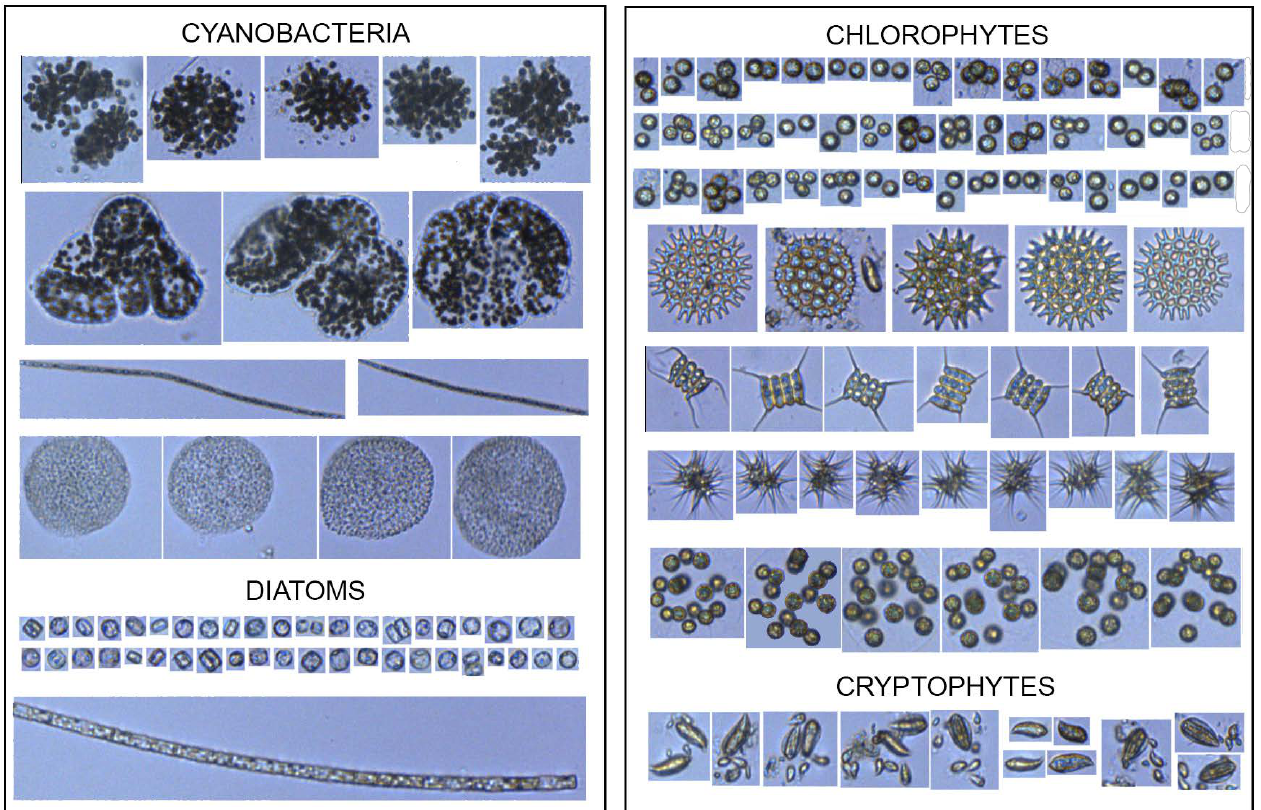
Figure 4. FlowCAM image library showing the different phytoplankton groups (10 ×